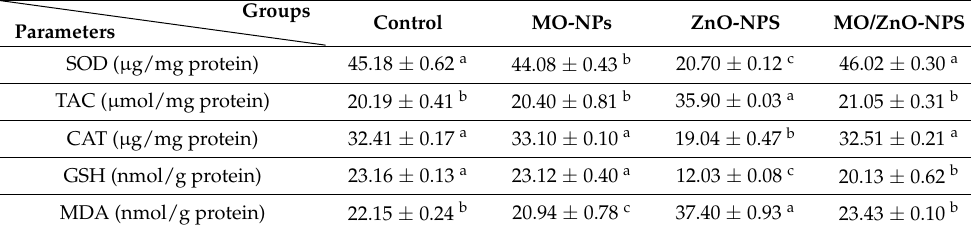
Table 5. Changes in liver antioxidant enzymes and malondialdehyde (MDA) levels (mean ± SD) of Nile tilapia , O. niloticus , exposed to ZnO-NPs with MO leaves nanoparticles administration for 2 months.